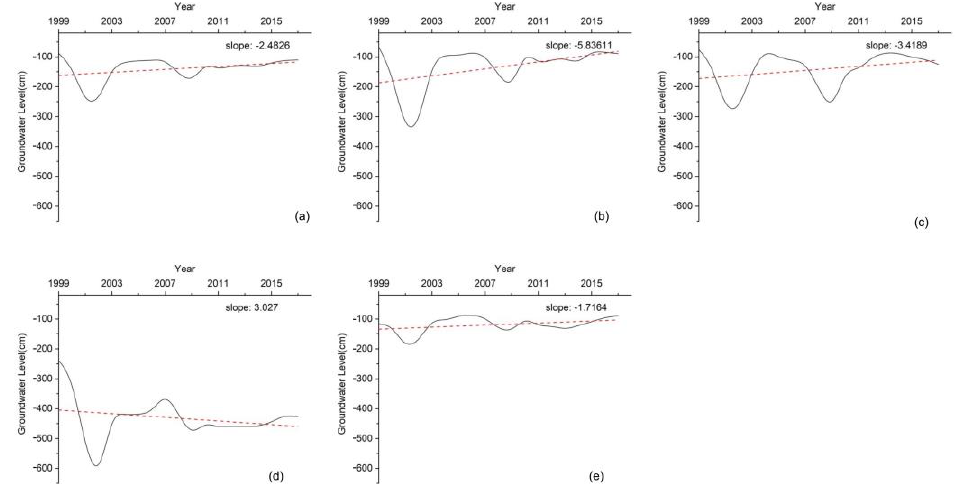
Figure 5. Annual groundwater level variations and trends in the Amu Darya Delta from 1999 to 2017 in Karakalpakstan ( a ), Karauzyak ( b ), Kungrad ( c ), Muynak ( d ), Nukus ( e ).